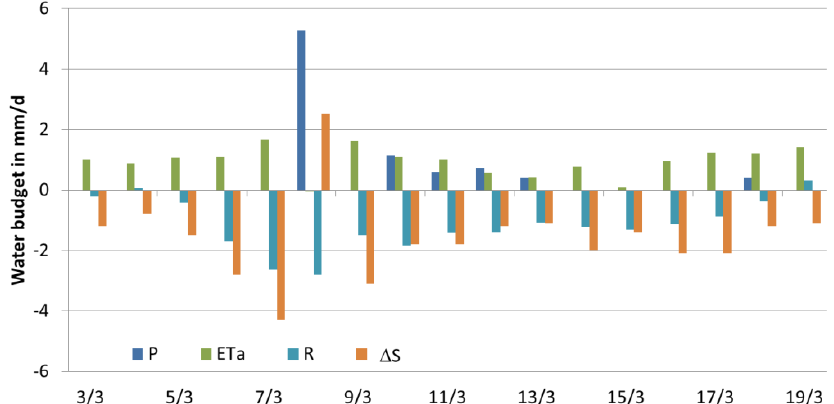
Figure A1. Water table (WT), lysimeter mass (mLy) and corrected lysimeter mass (mLy corr = mLy − P + ETa) in March 2012. The data served as basis for estimation of quasi-equilibrium water storage curve.